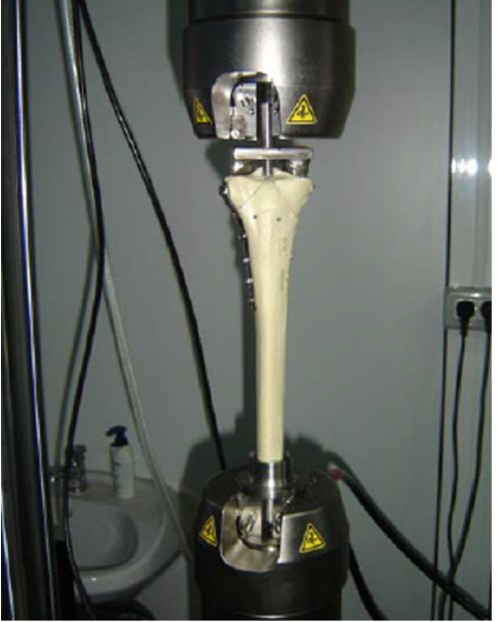
Figure 11. The distal and proximal securing system.